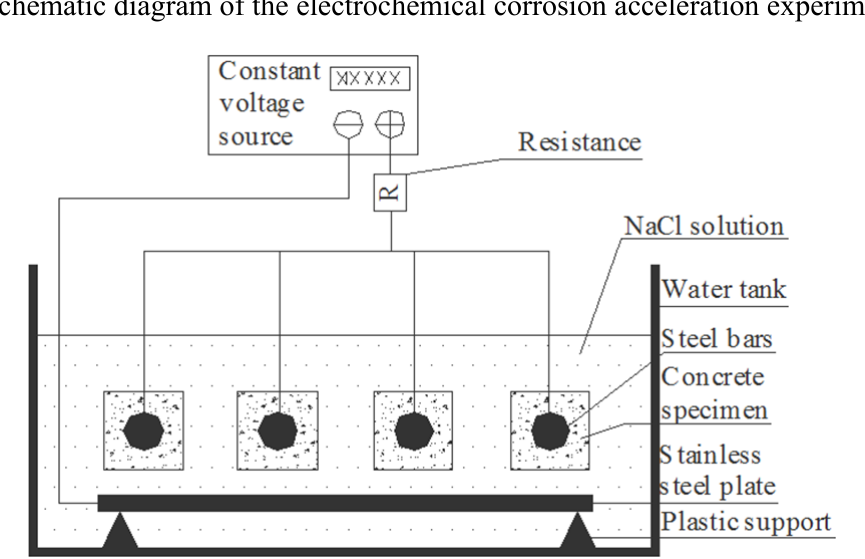
Figure 8. Schematic diagram of the electrochemical corrosion acceleration experiment system.